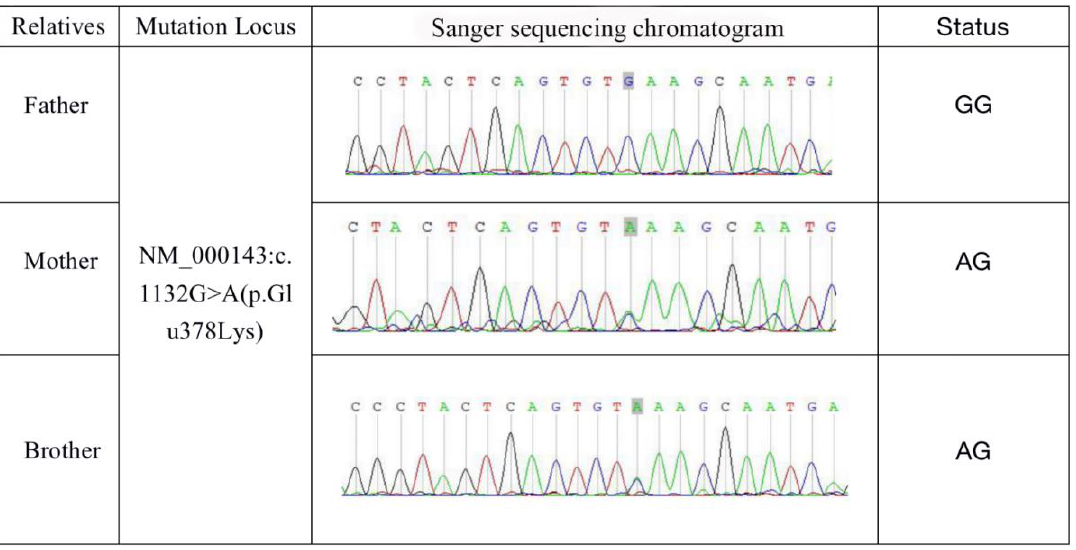
Figure 2. Sanger sequencing test results of Case 1. The spot mutation (gray square) was tested in family members accessible of Case 1.